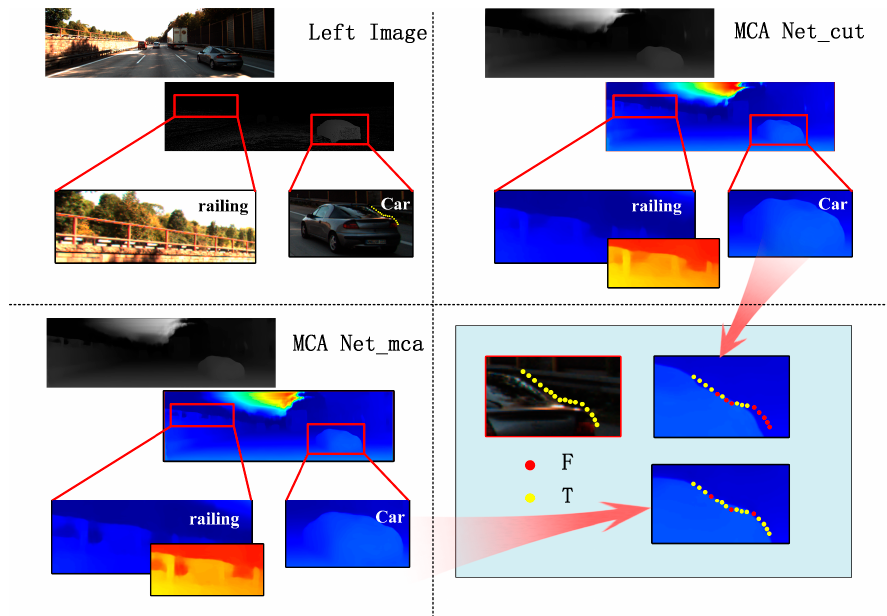
Figure 9. The results of the multi-cross attention module ablation experiment on KITTI2015. After adding the MCA module, the edge details of the railing have been added, and the background and foreground have become more distinct. At the same time, the shape radian of the car on the right side is obtained more obviously. The yellow points are right points as well as the red points are error points. The number of red points decreases after adding our module.